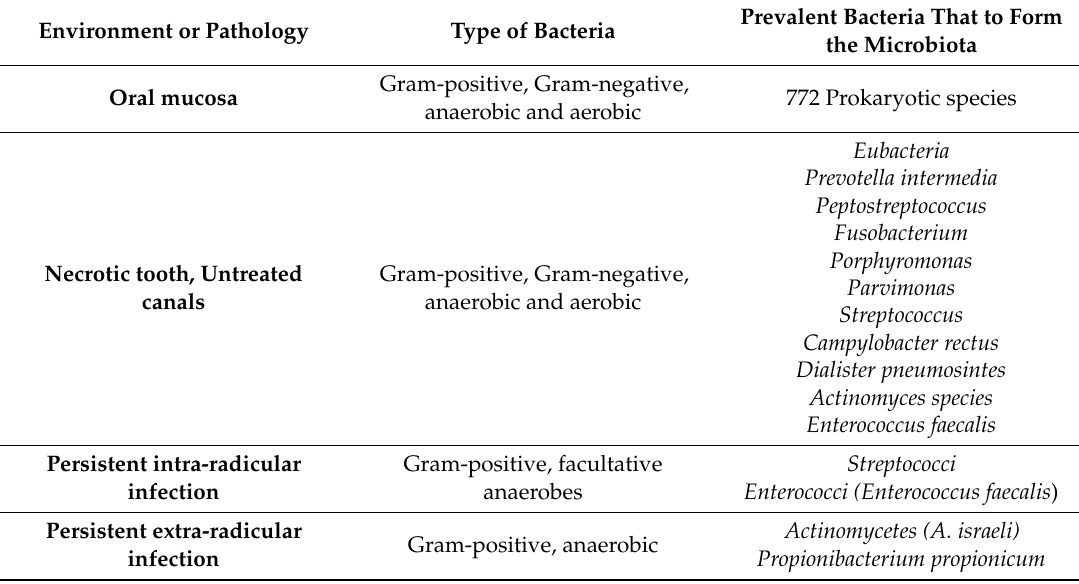
Table 4. Microbiota found in the